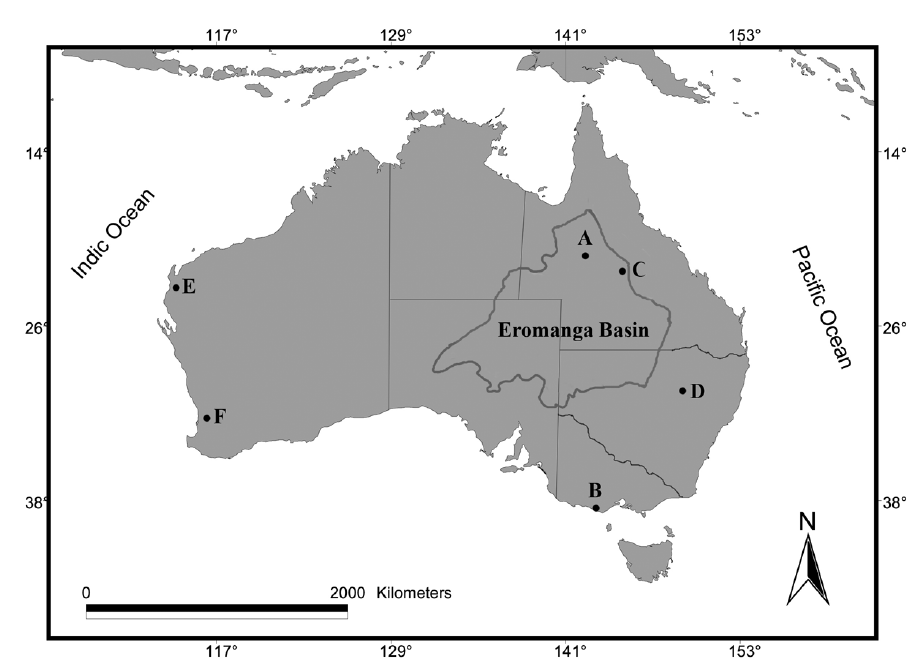
Fig. 1 – Australian pterosaur sites: (A) Toolebuc Formation (Albian); (B) Dinosaur Cove (Aptian/Albian); (C) Winton Formation (Albian); (D) Lightning Ridge (Albian); (E) Miria Formation (Maastrichtian); and (F) Molecap Greensand (Cenomanian/Conician). Adapted from Molnar and Thulborn (2007).